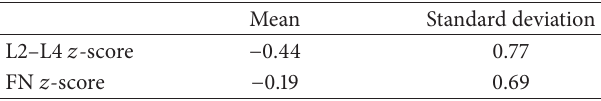
Table 2: Mean value for bone mineral density 𝑧 -scores for lumbar spine and femoral